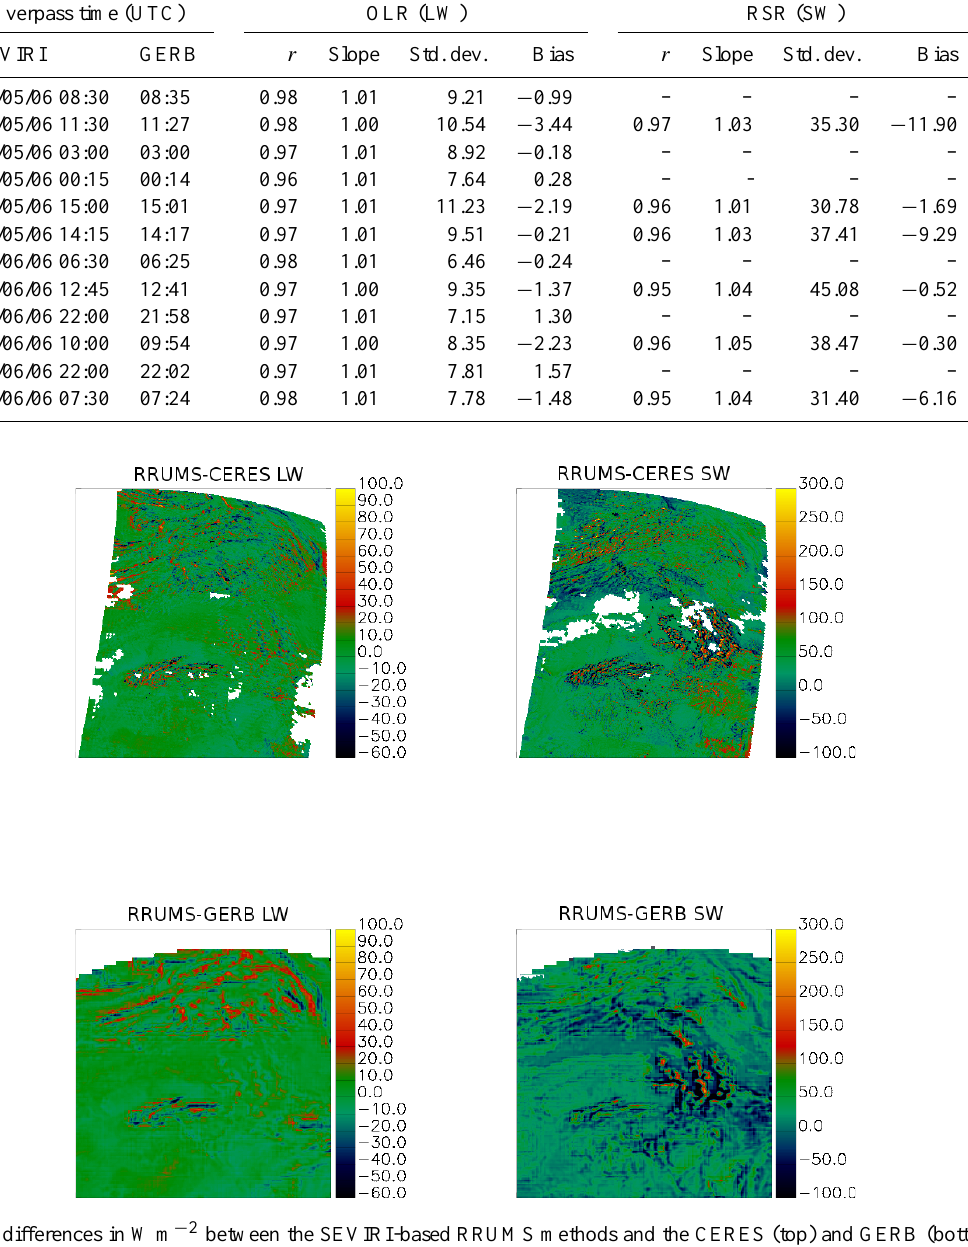
Fig. 11. Absolute differences in Wm − 2 between the SEVIRI-based RRUMS methods and the CERES (top) and GERB (bottom) measure- ments in both LW (left) and SW (right). The higher differences are found around cloudy areas. Date: 1 January 2007,